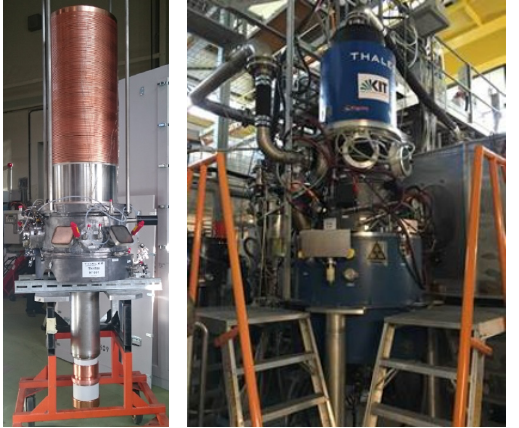
Fig. 1. TH1509 gyrotron prototype (left) and the same gyrotron installed in the KIT test stand (right), in Karlsruhe (Germany) .